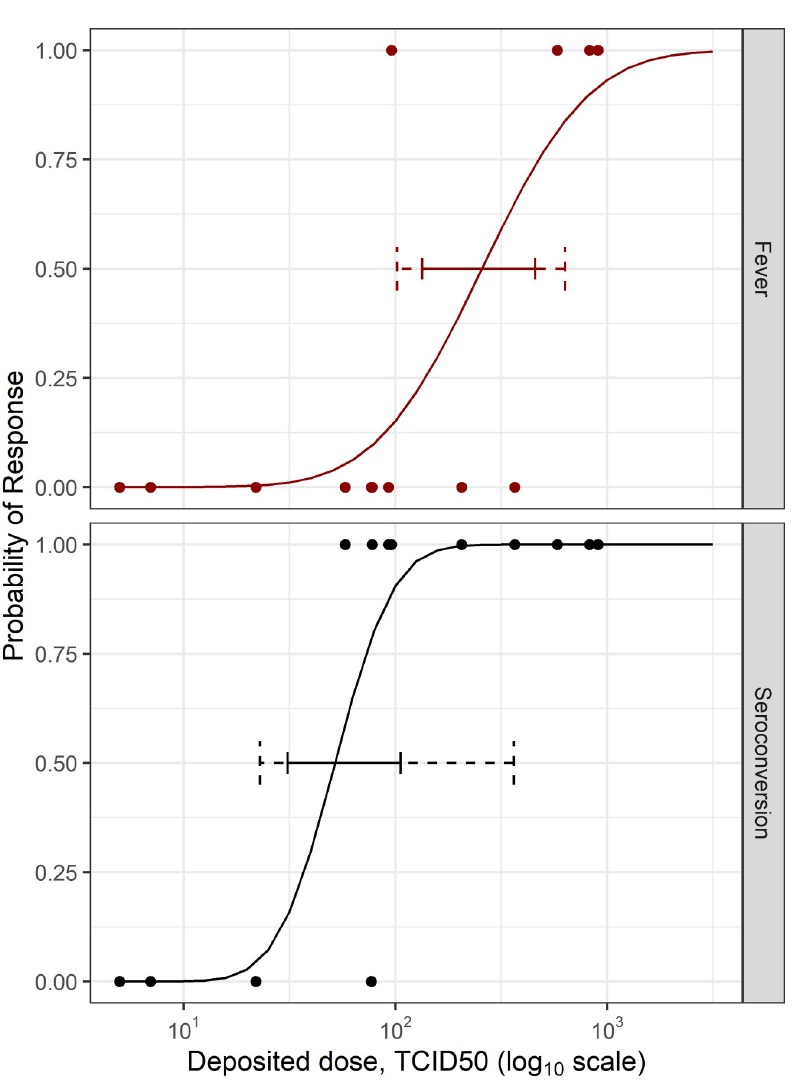
Fig 1. Dose-response relationships for fever and seroconversion. The dashed and solid horizontal line segments indicate the 95% and 85% bias-corrected and accelerated bootstrap percentile confidence intervals, respectively. For fever, the estimated median dose was 256 TCID 50 , with 95% and 85% confidence intervals of 102–633 TCID 50 and 134–458 TCID 50 , respectively. For seroconversion, the estimated median dose was 52 TCID 50 , with estimated 95% and 85% confidence intervals of 23–363 TCID 50 and 31–106 TCID 50 , respectively. The median deposited dose for seroconversion was significantly lower than that estimated for fever when compared using the LRT (P = 0.03).